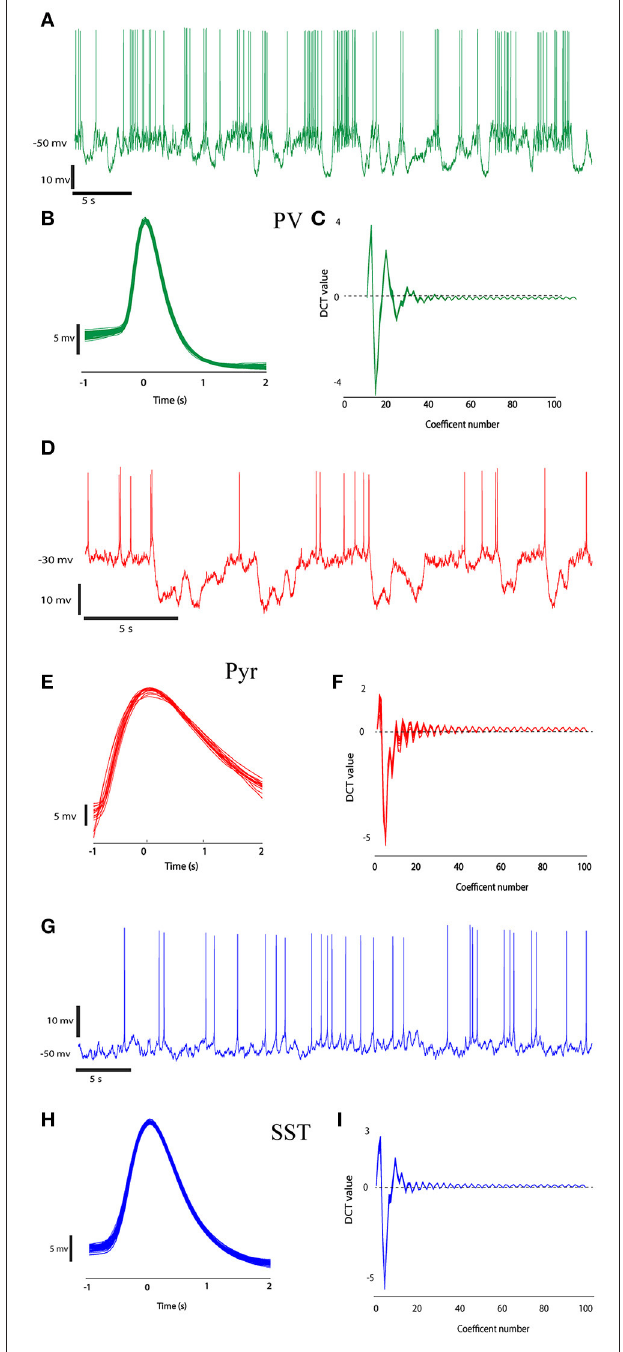
FIGURE 2 | The recorded data from three different neuron types (PV, Pyr, and SST). Recorded raw data (A,D,G) and the ensemble of spikes extracted from the raw data by windowing over the spikes’ peaks at second column (B,E,H , 1ms before peak to 2ms after each spike peak). (C,F,I) shows DCT coefficients extracted from their spikes waveform.